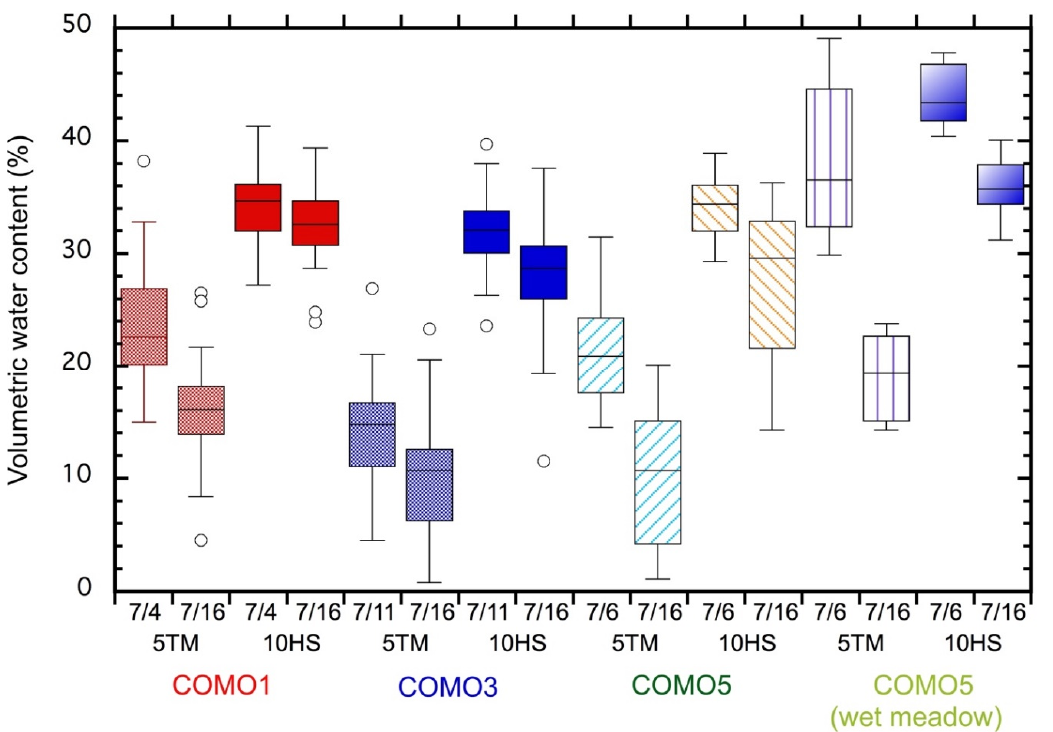
Figure 7. Box-and-whisker visualization of repeated soil moisture transects at three Niwot Ridge sites showing overall decreases in volumetric water content at both 5- and 10-cm depths over peri- ods of 12, 5, and 10 days for COMO1, COMO3, and COMO5, respectively (Supplementary Material). Transects COMO1 and COMO3 were 30 m long and included 31 measurements at each depth.